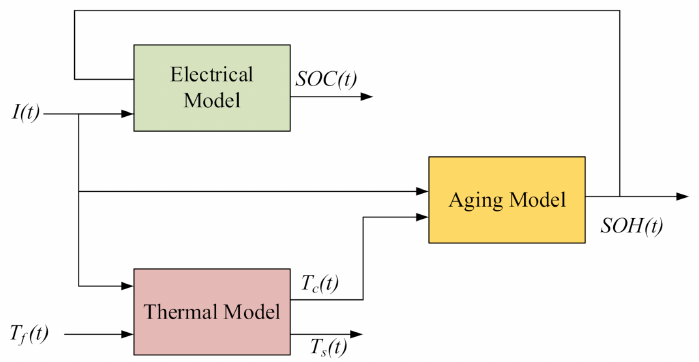
Figure 1. Electro-Thermal-Aging model